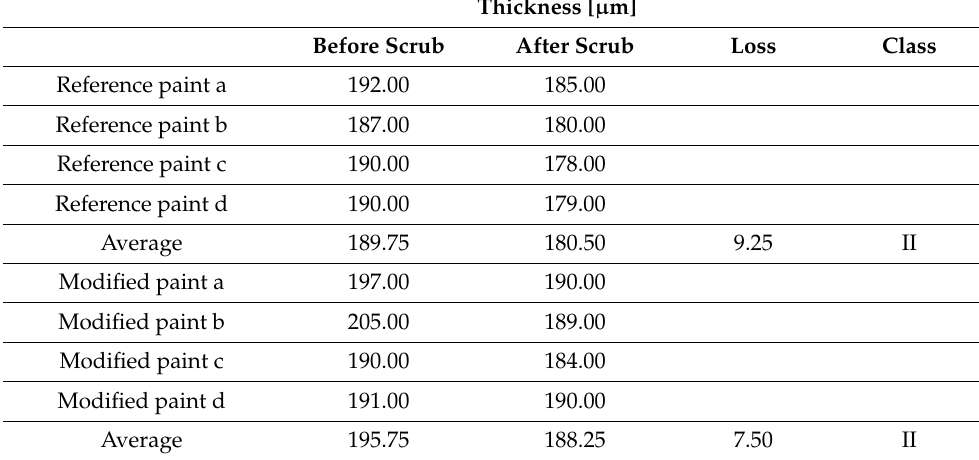
Table 5. Wet-scrub